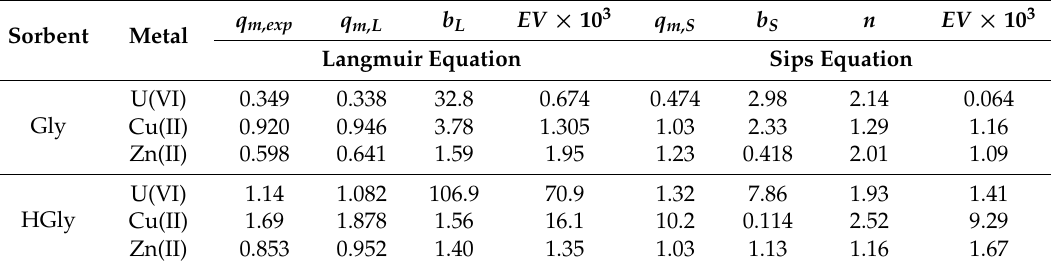
Table 3. Sorption isotherms for U(VI), Cu(II), and Zn(II) recovery using Gly and HGly sorbents—Modeling with the Langmuir and the Sips equations.